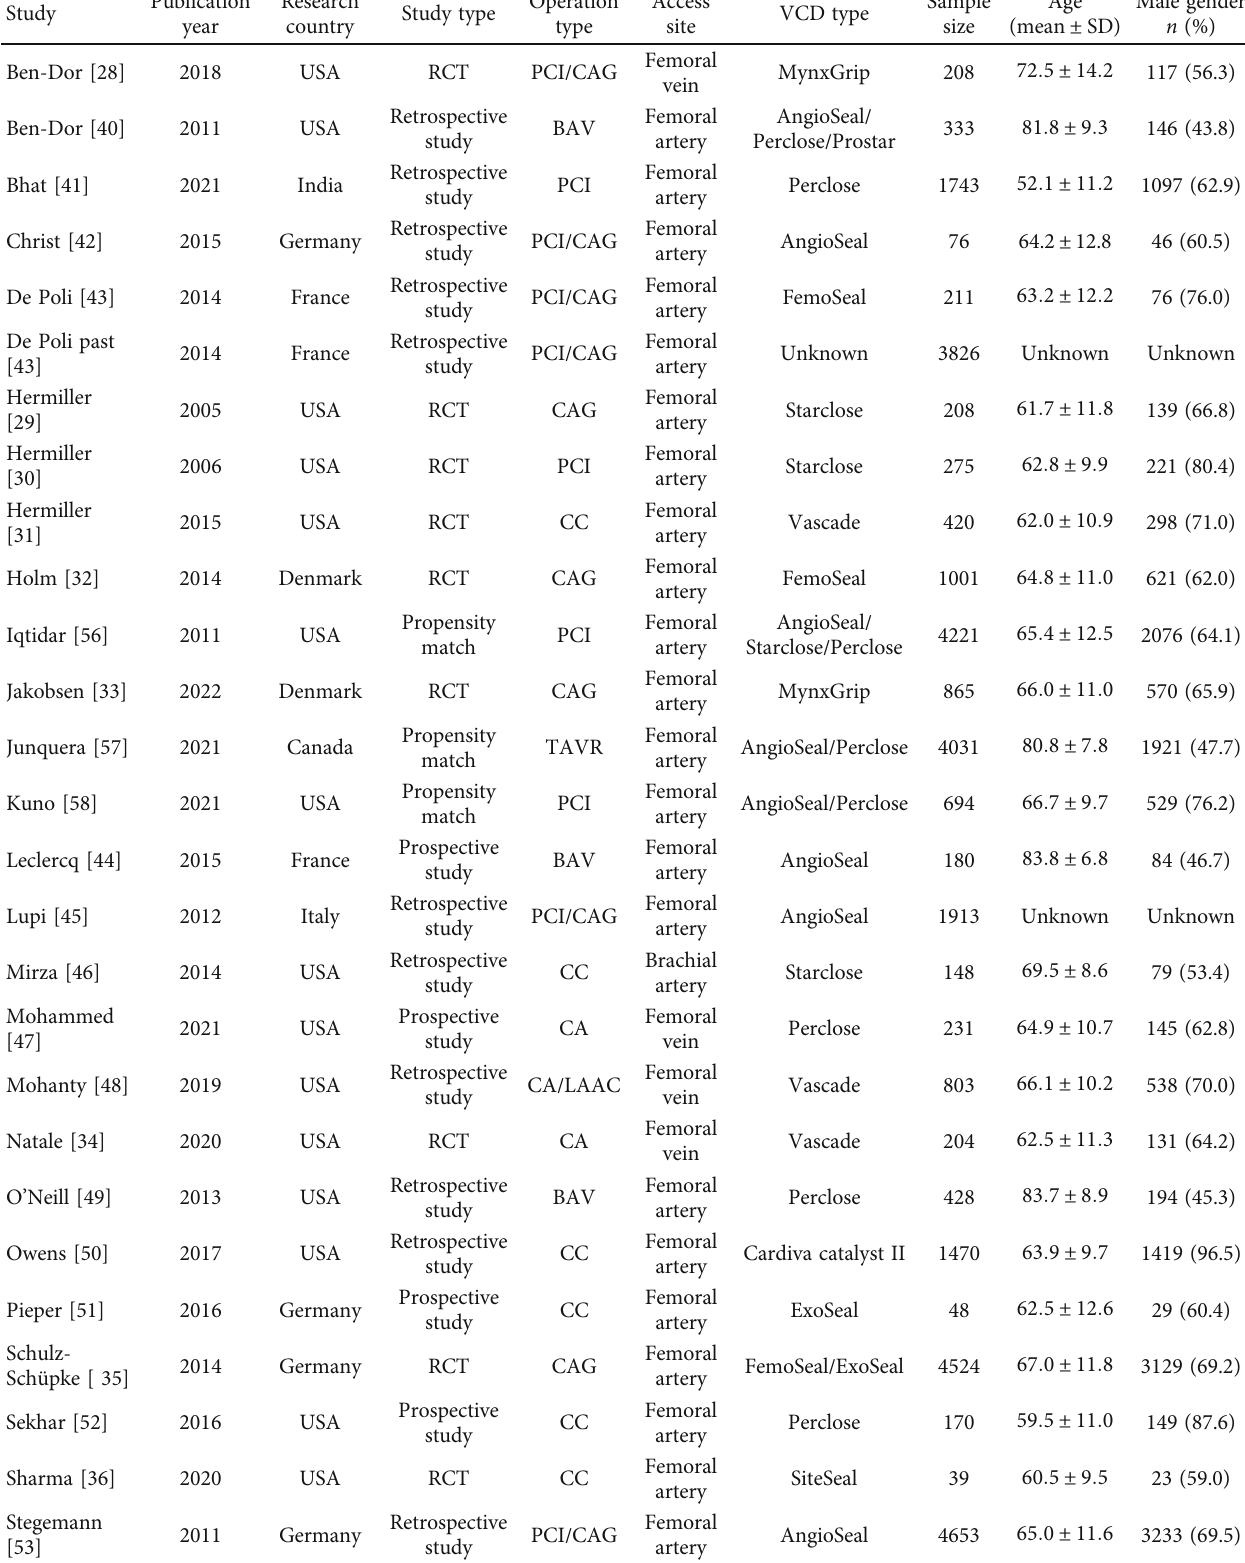
Table 1: Summary of included